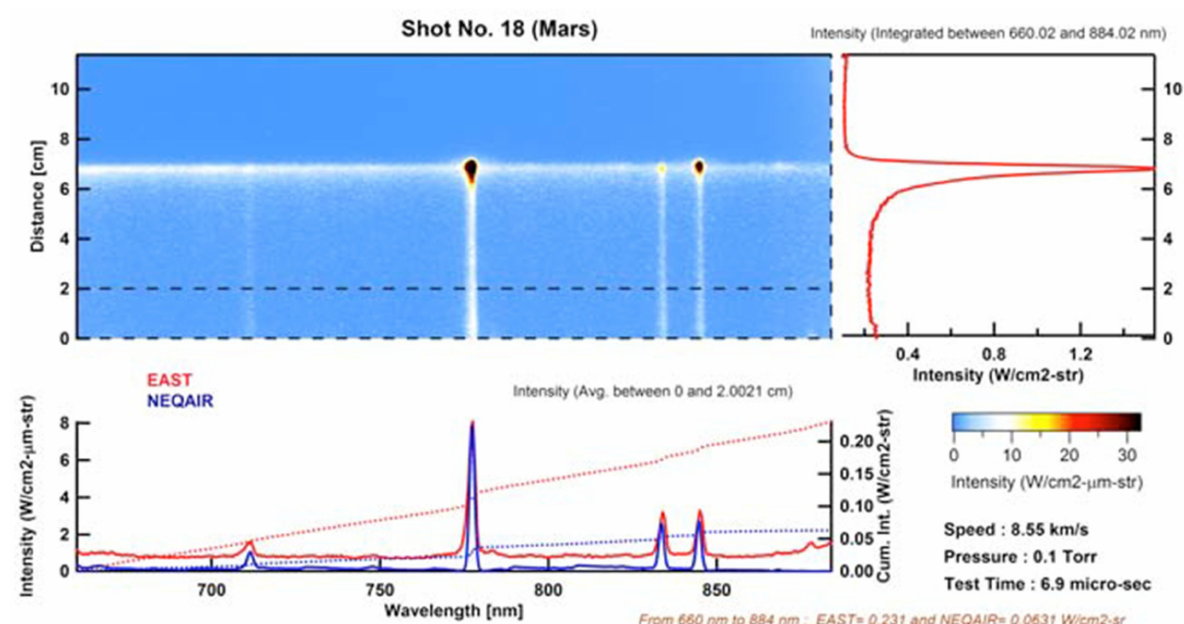
Figure 21. Comparison between NEQAIR calculations and EAST data in the NIR range at 0.1 Torr and a shock velocity of 8.55 km/s. The dotted curves are the cumulated intensity: measured in red and computed in blue (from [24]).